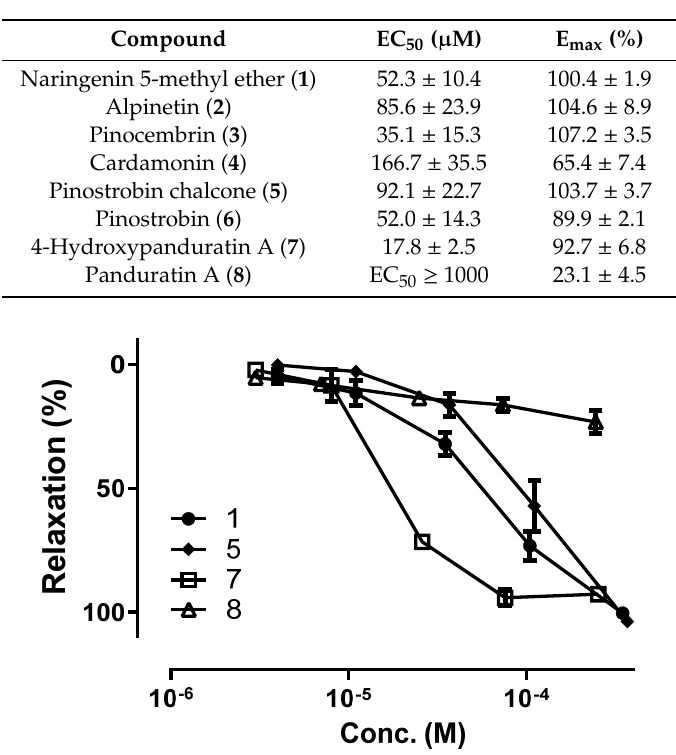
Figure 5. Concentration-response curves illustrating the vasorelaxant e ff ect of naringenin 5-methyl ether ( 1 ), pinostrobin chalcone ( 5 ), 4-hydroxypanduratin A ( 7 ) and panduratin A ( 8 ). Results are shown as mean ± SEM of 5–10 experiments.